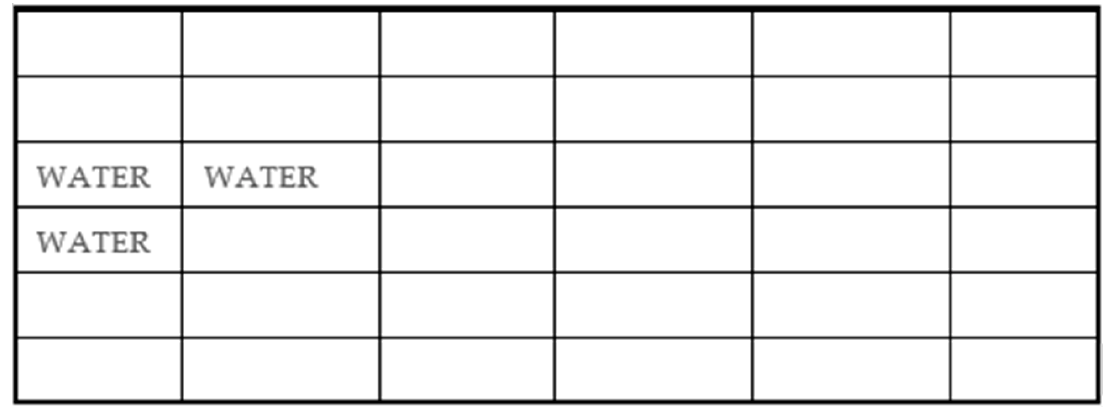
Figure 7. Best match tempmem <x> from the Causal Memory. Module of the starting WNM’ <x> (Equa- tion (88)). Figure 8. This is the Working Navigation Map WNM’ <y> that occurred after the best match temp- mem <x> in the past and retrieved again now (Equation (89)). Figure 9. This is the difference WNM’ <B> of WNM’ <y> . minus tempmem <x> (Equation (90)).